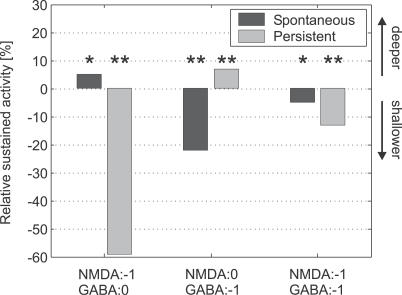
Stability of the Spontaneous and Persistent StatesWe assessed how often in 100 trials the average activity during the last second (2–3 s) stayed above 10 Hz. The value shows how often it stayed more in the respective state than in the unmodulated reference state. A negative percentage means that the system was less stable than in the reference state. A modulation of the synapses shown as −NMDA and −GABA corresponds to a reduction of 4.5% and 9% in their efficacies, respectively. We assessed with the binomial distribution the statistical significance of the effects observed; **p < 0.01 relative to the reference state, and *p < 0.02.